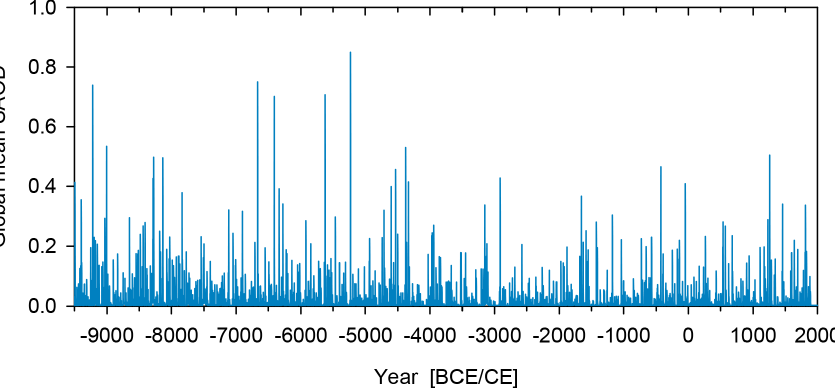
Figure 9. Global annual mean stratospheric aerosol optical depth (SAOD) from the EVA(HolVol) reconstruction. Years are shown using the ISO 8601 standard, which includes a year zero.